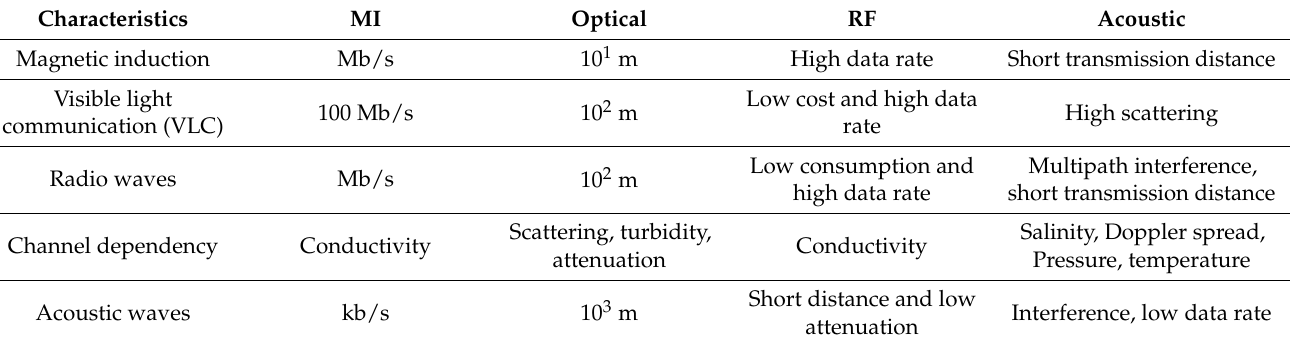
Table 6. Differences between underwater communication